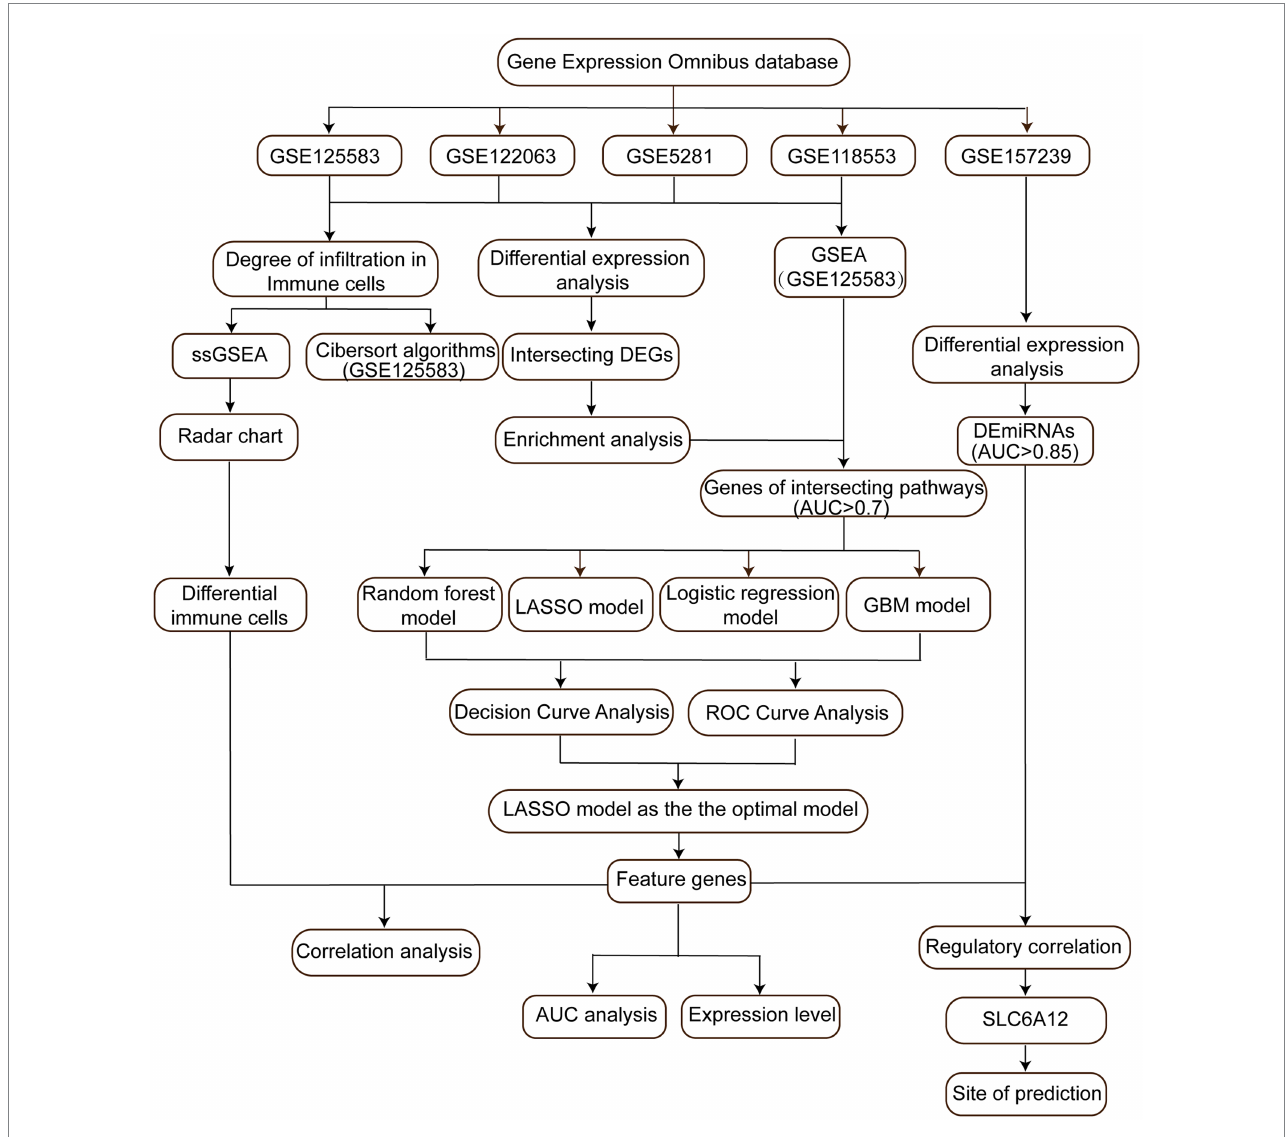
FIGURE 1 Flow chart of study. AUC, area under the curve; DEGs, differentially expressed genes; DEmiRs, differentially expressed microRNAs; GBM, gradient boosting machine; LASSO, least absolute shrinkage and selection operator; ssGSEA, single-sample gene set enrichment analysis; ROC, receiver operating characteristic